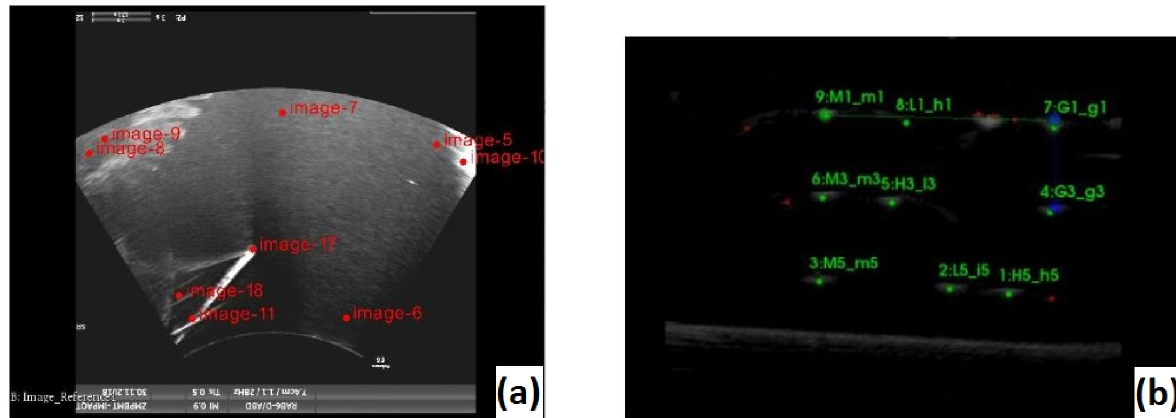
Fig 5. 2D spatial US calibration techniques: By applying the pointer method, fiducials were collected on the image by looking at the maximum intensity profile of the pointer tip on the image (Fig 5(a) ). N-shaped wires are seen as dots on the images which are detected and segmented by the PLUS software. The result of the segmentation can be identified as the green cursors (see Fig 5(b) ).